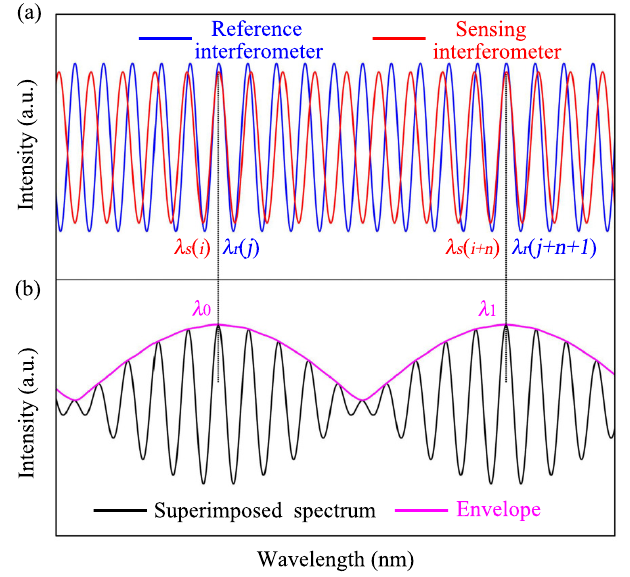
Figure 2. Working mechanism of the optical Vernier effect: ( a ) spectrum of the sensing and reference FI; ( b ) superimposed spectrum of the parallel connected